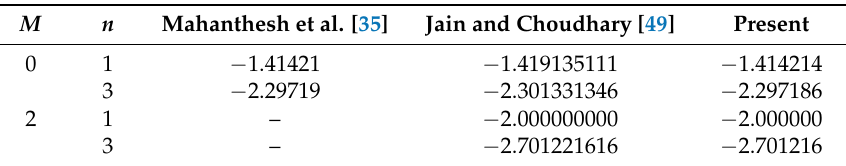
Table 2. Numerical values of f (cid:48)(cid:48) ( 0 ) for several values of M and n .